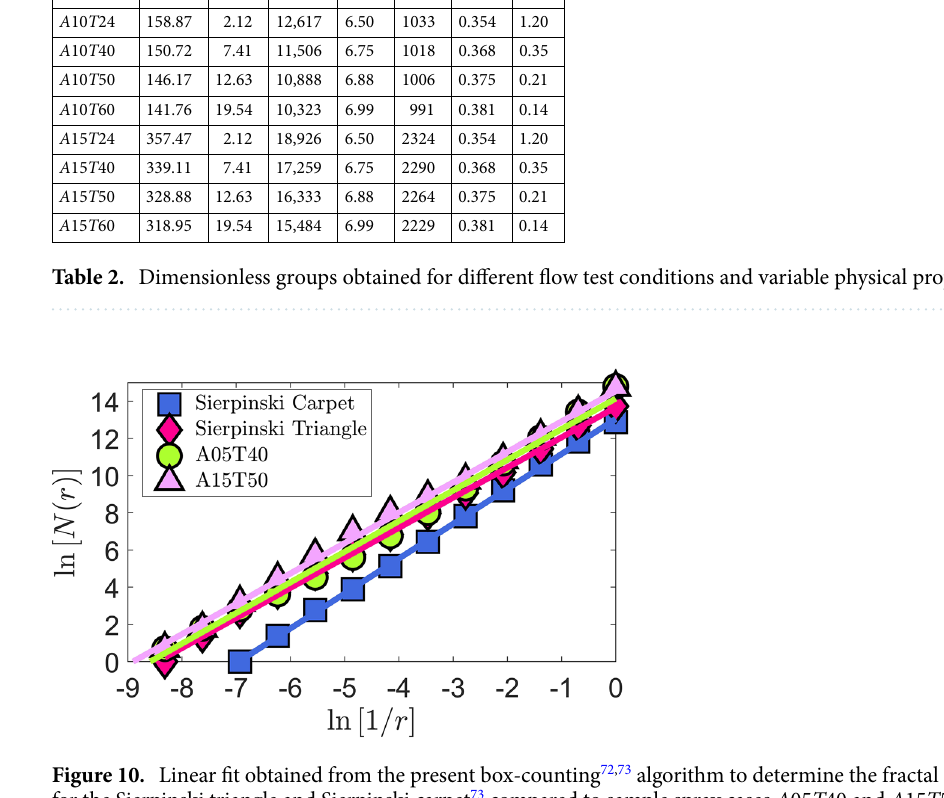
the grid size and extracting the cells representing the complexity of the two-phase flow structure, the so-called “box-counting” algorithm 72,73 . For each of the 15 flow cases, fractal dimension statistics are evaluated by analys- ing 1000 high-resolution snapshots. A systematic approach is taken to pre-process the images before they can be properly used for fractal analysis. All the RGB images are first converted into gray-scale and normalised to represent liquid fraction. Five images are taken from the background light source to obtain the average back light intensity. The averaged field is then subtracted form all the instantaneous images. In order to correct for the out of focus liquid structures images are slightly de-blurred and then binarized with zero pixels in the background. To start the box-counting algorithm, images are padded into a pixel dimension at a power of 2. The box size r is initialized equal to the image size. Then, number of boxes of size r containing a minimum of one liquid pixel are counted as N ( r ). This process is continuously repeated by setting r = r 2 as long as r > 1 . The resulting logarithmic data points ( ln N ( r ) vs . ln ( 1 / r ) ) are fitted to a linear function using the method of least squares. As shown in Fig. 10, the linear fits nicely represent the data points evaluated for the two test cases of the Sierpinski triangle and Sierpinski carpet compared to the sample spray cases A 05 T 40 and A 15 T 50. The slope of these lines gives the fractal dimension ( D ) of the image. In order to verify the present box-counting approach, Fig. 11 demonstrates a set of geometrical structures with known Hausdorff dimensions. Fractal dimension values from the present box-counting compared to their corresponding Hausdorff dimensions and the error estimation are summarized in Table 3. It can be seen that the present study robustly evaluates the fractal dimensions of geometrically complex structures. Since nearly all of the fractal dimension values are slightly underestimated, the accuracy could be further improved by using higher resolution images. These geometrical patterns are carefully selected to cover a range of fractal dimensions expected from the present measurements. In addition, these benchmark structures exhibit diverse shapes and patterns suitable for testing the present algorithm.